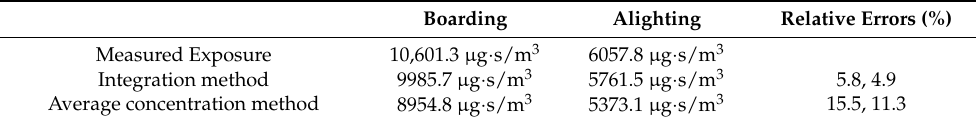
Table 8. PM2.5 Exposure calculation results and errors of different